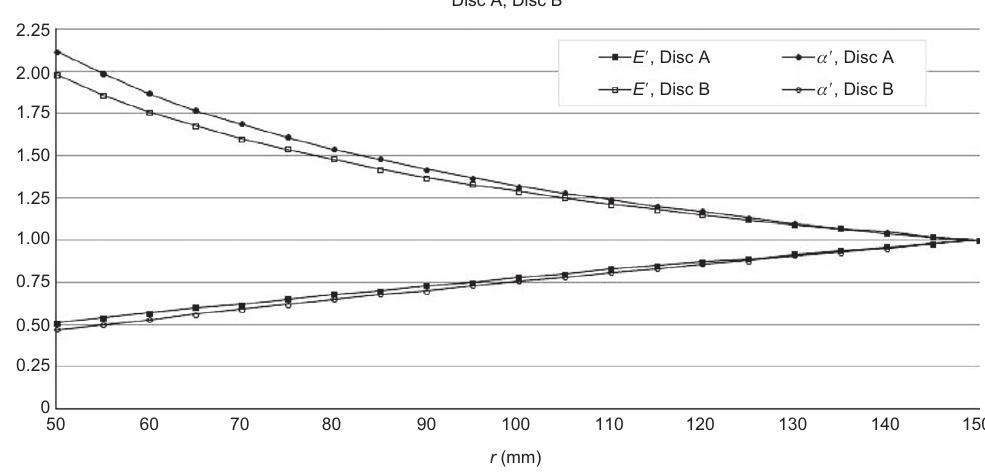
Figure 2 Variations of the normalized elasticity modulus and thermal expansion coefficient (normalized values) for Disc A and